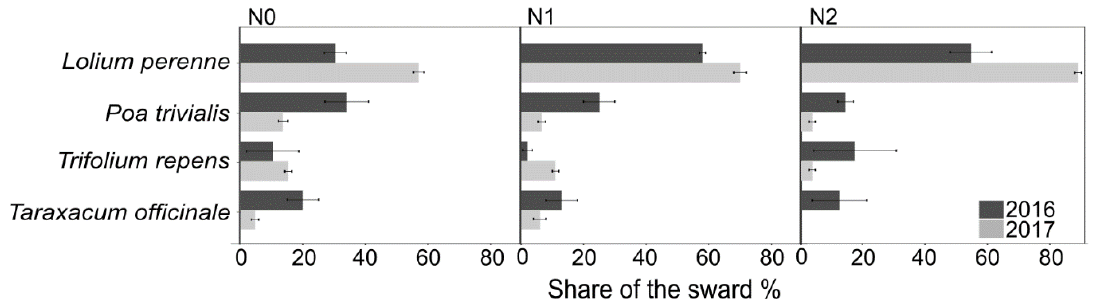
Figure A1. Share (%) of the four most dominant species in the swards examined in the study. Visual estimations in autumn 2016 and 2017 was conducted according to Klapp and Stählin [62].